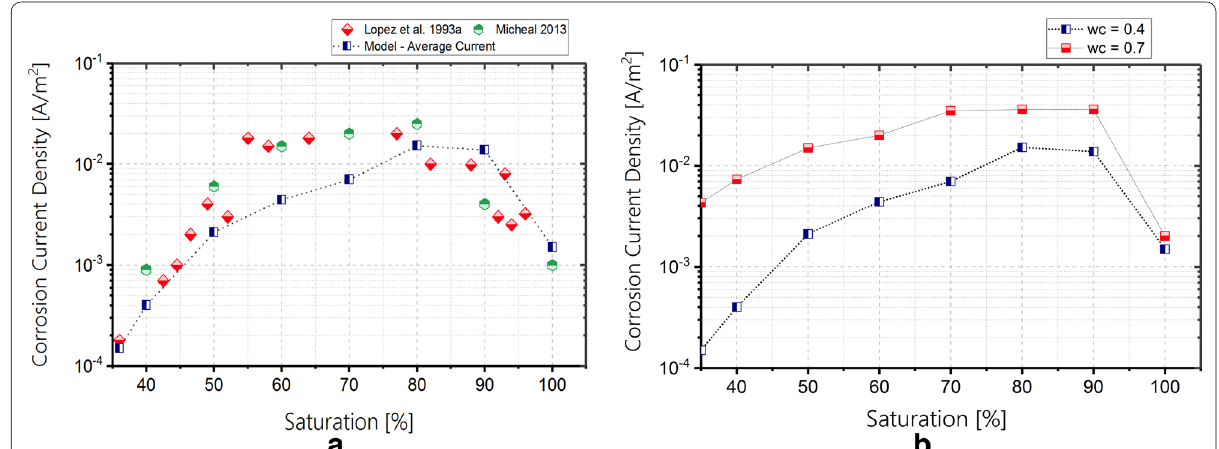
Fig. 10 a Comparison of average corrosion current density at the activated area and comparison with works of Michel (2013) and Lopez and Gonzalez (1993) across different ranges of saturation. b Parametric studies of corrosion current for w/c 0.4 and 0.7 across different ranges of